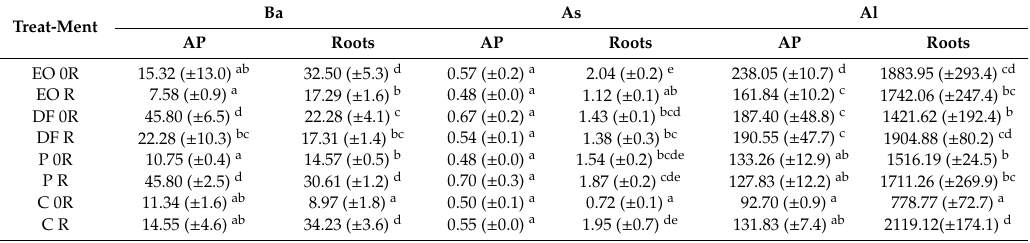
Table 8. The e ff ect of petroleum-derived substances and bioremediation on the content of barium, arsenic and aluminium in the aboveground parts (AP) and roots of Vicia faba L. (mg kg − 1 ). Ba Treat-Ment